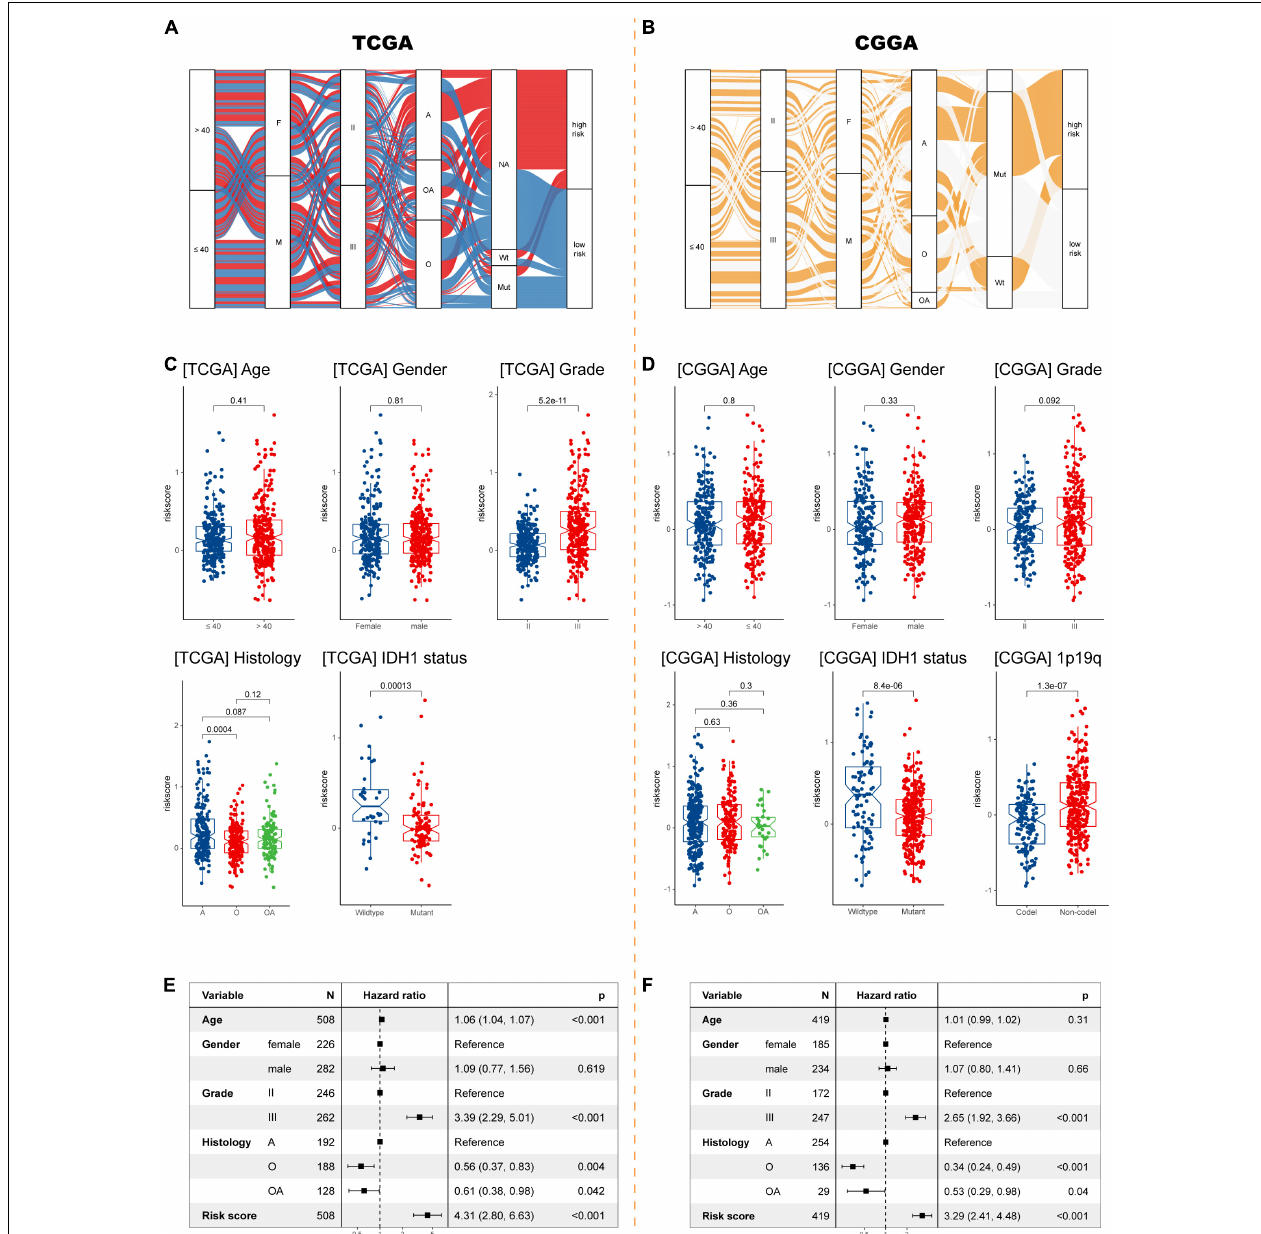
FIGURE 4 | Exploration the relationship between clinicopathologic characteristics and the IIRS. (A,B) Sankey diagrams exhibiting the distribution of clinicopathologic characteristics in high- and low-risk groups in the two cohorts. (C,D) The risk score in different subgroups stratified by age, gender, grade, histological type, IDH1 status, and 1p/19q codeletion status in the TCGA and CGGA cohorts. (E,F) Cox analyses examining different variables for LGG patient survival in the TCGA and CGGA